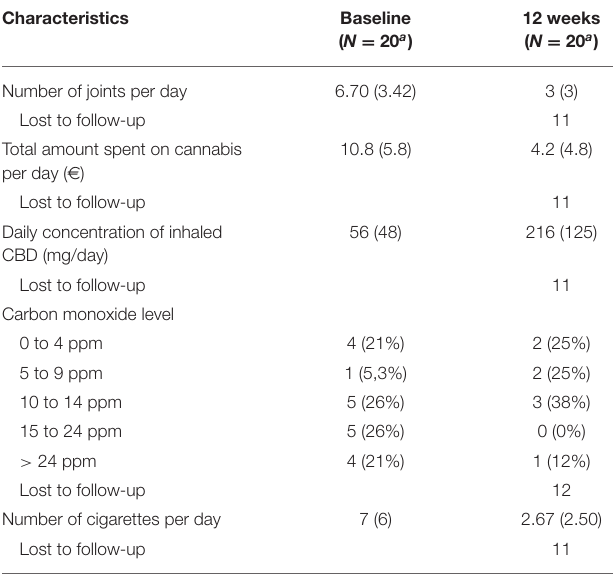
TABLE 4 | Change in consumption between baseline and 12